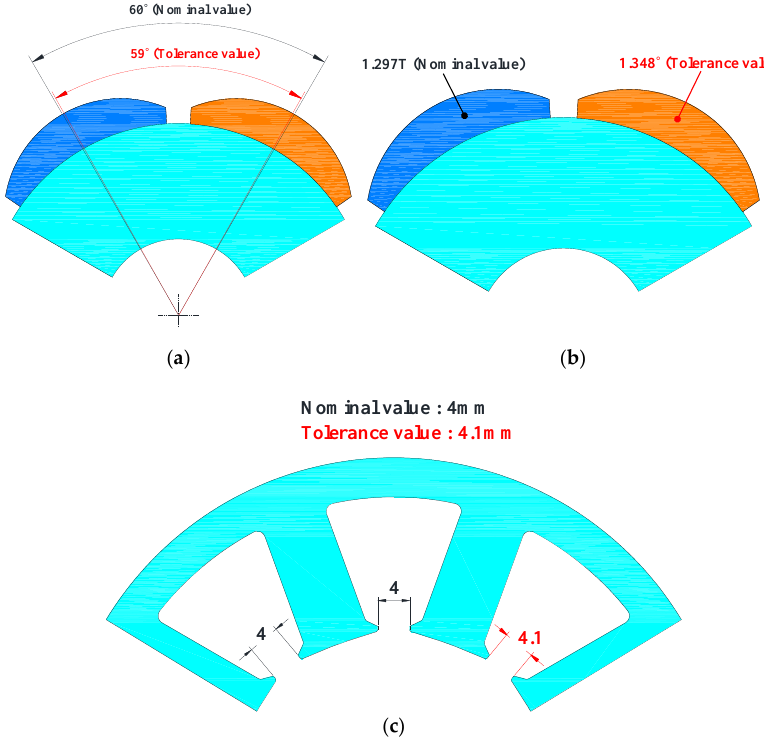
Figure 9. Typical manufacturing tolerance models of motors: (a) fabrication tolerance for position of permanent magnet; (b) fabrication tolerance for residual magnetic flux density of permanent magnet; (c) fabrication tolerance for the width of open slot.